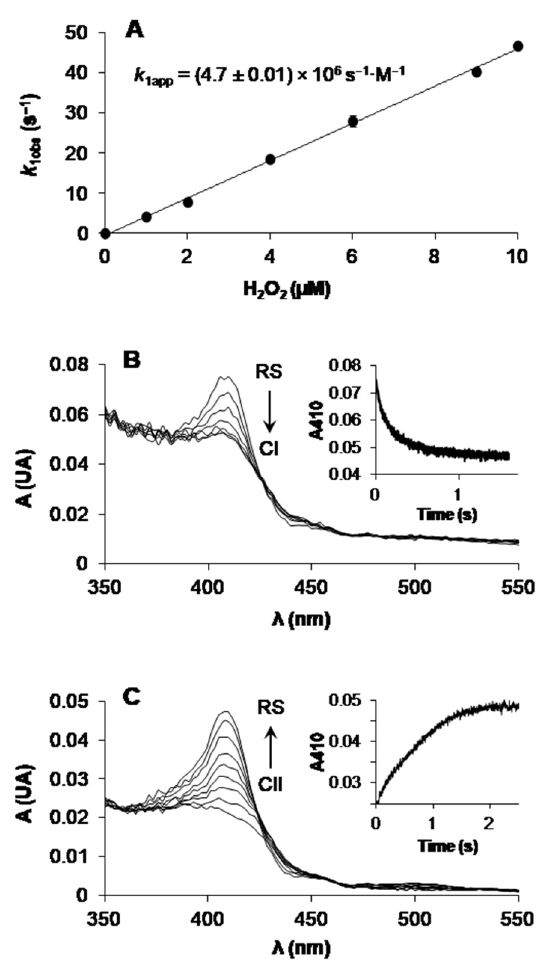
Figure 5. Stopped-flow spectrophotometric analysis of ApeLiP. ( A ) CI formation by H 2 O 2 followed at 397 nm (means and 95% confidence limits are shown). ( B ) Spectral changes upon mixing RS enzyme with H 2 O 2 to attain the RS/CI equilibrium. ( C ) Spectral changes upon mixing CII enzyme (formed by adding 2.5 equiv of H 2 O 2 and 1 equiv of ferrocyanide) with tyrosine to attain the CII/RS equilibrium. The insets show time traces at the Soret band (410 nm) to attain equilibrium concen- trations. All reactions were carried out at pH 3 and 25 °C. See Tables S1 and S2 for estimation of the E°’(CI/RS) and E°’(CII/RS) values,